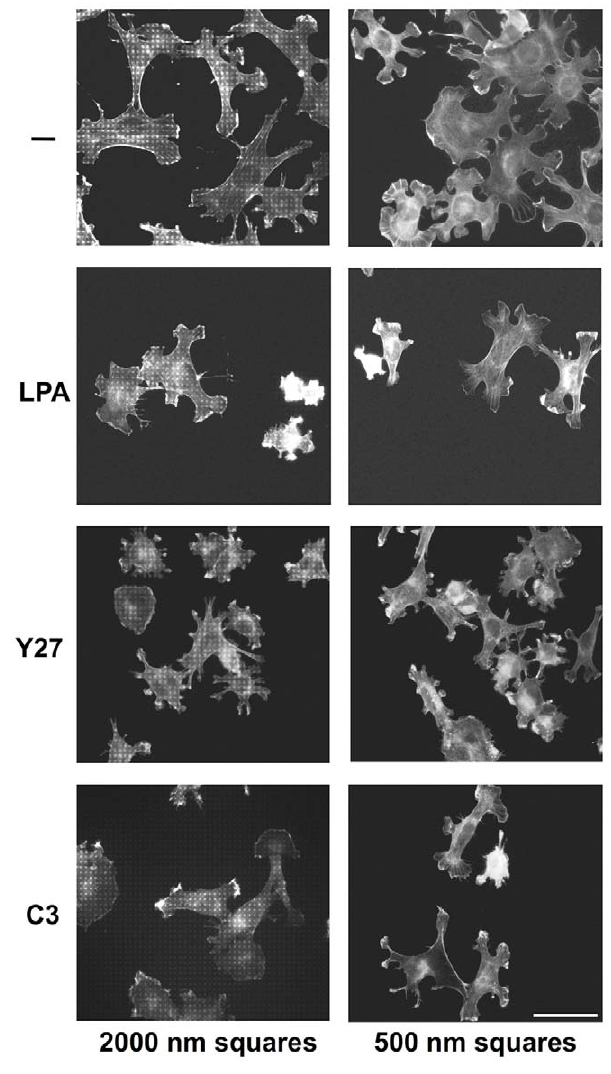
Figure 8. Effect of RhoA/ROCK activation and inhibition on nanopattern-controlled cell shape. Fibroblasts were seeded onto RGD-coupled 2000 nm and 500 nm gold patterns in medium with 3% fibronectin-free FCS. Cells were allowed to attach and spread for 4 hours, before medium was changed against the same medium either without drug (control) or with 5 m M lysophospatitic acid (LPA), 5 m M Y27632 (Y27), or 0.25 m g/ml C3 exoenzyme (C3), respectively. After an additional 2 hours, cells were fixed and stained for F-actin with Alexa- labeled phalloidin. Note the difference in cell morphology between the 2000 nm and the 500 nm pattern in control medium. LPA (RhoA activator), Y27632 (ROCK inhibitor) and C3 exoenzyme (Rho inhibitor) cause similar cell shape changes on both the 2000 nm and the 500 nm pattern, and morphological differences between patterns are lost. The experiment was repeated three times with comparable results; representative images from a single experiment are shown. Scale bar is 50 m